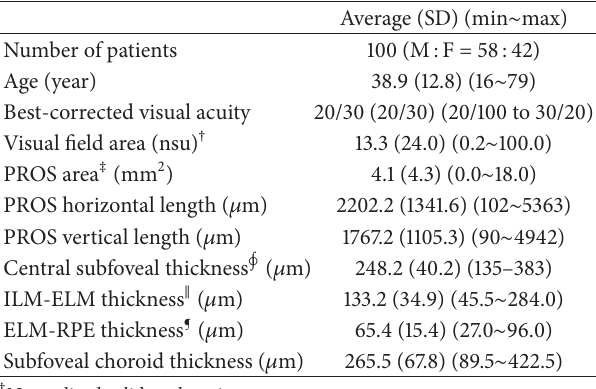
Figure 2: Scatter plot showing the PROS area measured by 2 different methods. The 𝑋 -axis depicts the area calculated from the horizontal and vertical PROS lengths measured at each cross- sectional, high-definition image. The 𝑌 -axis depicts the area cal- culated from an en-face image in the advanced visualization tool (Pearson correlation: 𝜌 = 0.953 , 𝑃 < 0.001 ). Table 1: Demographic